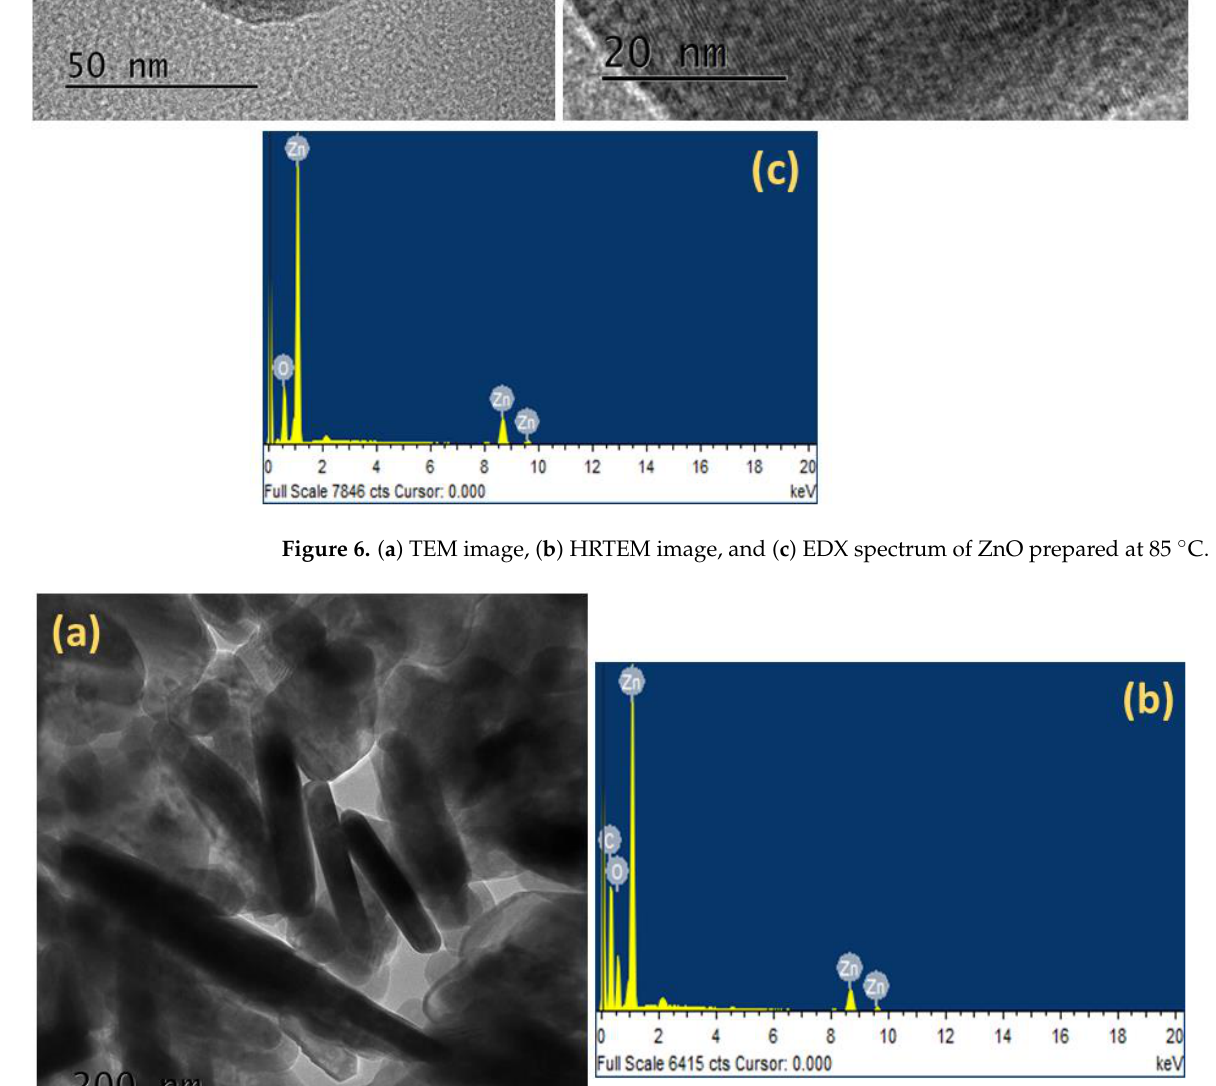
Figure 7. ( a ) TEM image, and ( b ) EDX spectrum of ZnO/RGO